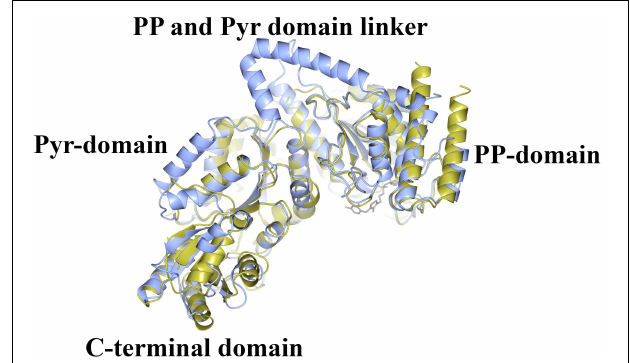
FIGURE 5 | A comparison of the structure of ChTK αβ heterodimer (gold) superimposed onto the monomer of EcTK (ice blue) showing the equivalent positions of the PP-domain, the Pyr-domain and the C-terminal domain. The linker between the PP and Pyr domains is present in EcTK but not in ChTK-F.